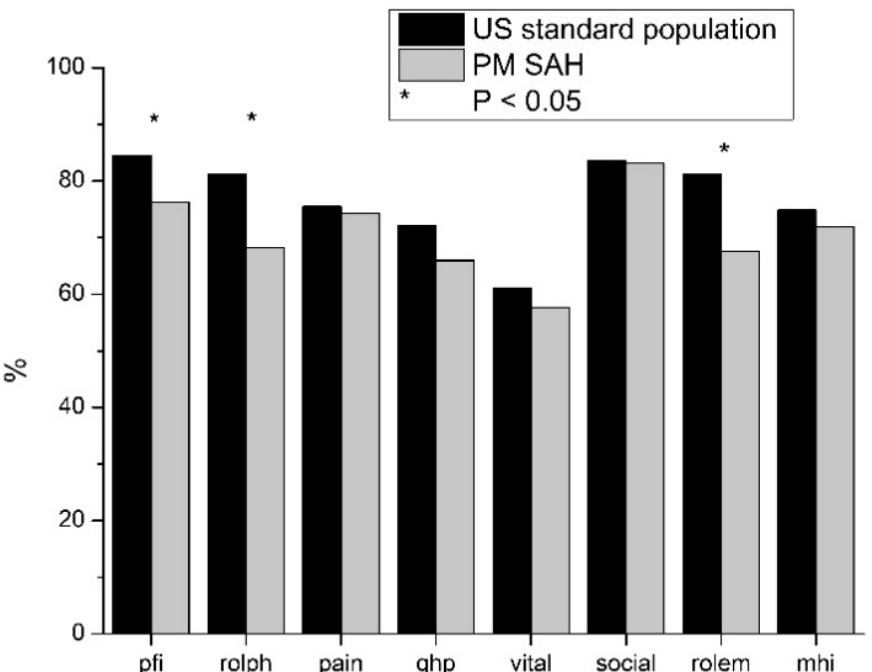
Figure 2. Comparison of outcome of patients with PM SAH and standard population. Long-term outcome compared to standard population, measured by SF-36. On the x-axis, the eight items of the SF-36 are shown, and the y-axis is scaled metrically. Standard population ( black ) was compared with PM SAH ( grey ). At long-term outcome, Pfi, rolph and rolem are significantly reduced after PM SAH compared to the standard population.